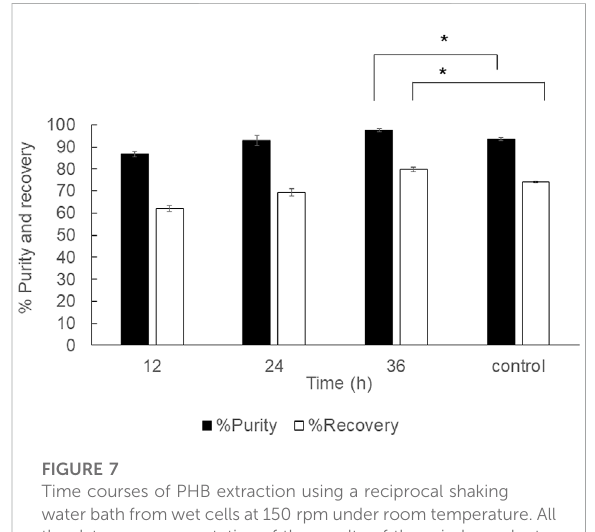
FIGURE 7 Time courses of PHB extraction using a reciprocal shaking water bath from wet cells at 150 rpm under room temperature. All the data are representative of the results of three independent experiments and are expressed as the mean values ± standard deviations (SDs). The asterisk indicates a signi fi cant difference ( p < 0.05).